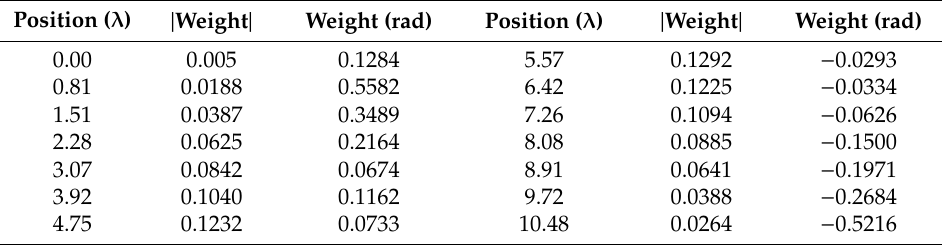
Table 5. Positions and weight values of the sparse linear array with asymmetric sidelobe BP.